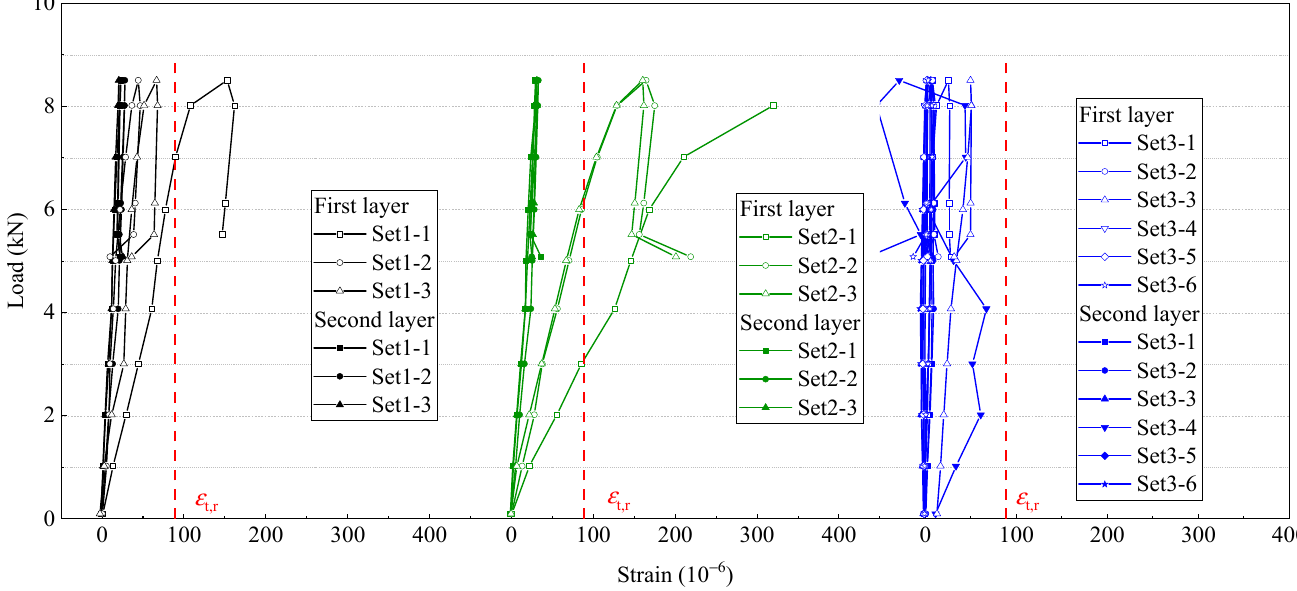
Figure 9. Strains on the surfaces of the rods changed with the load in the lifting test.